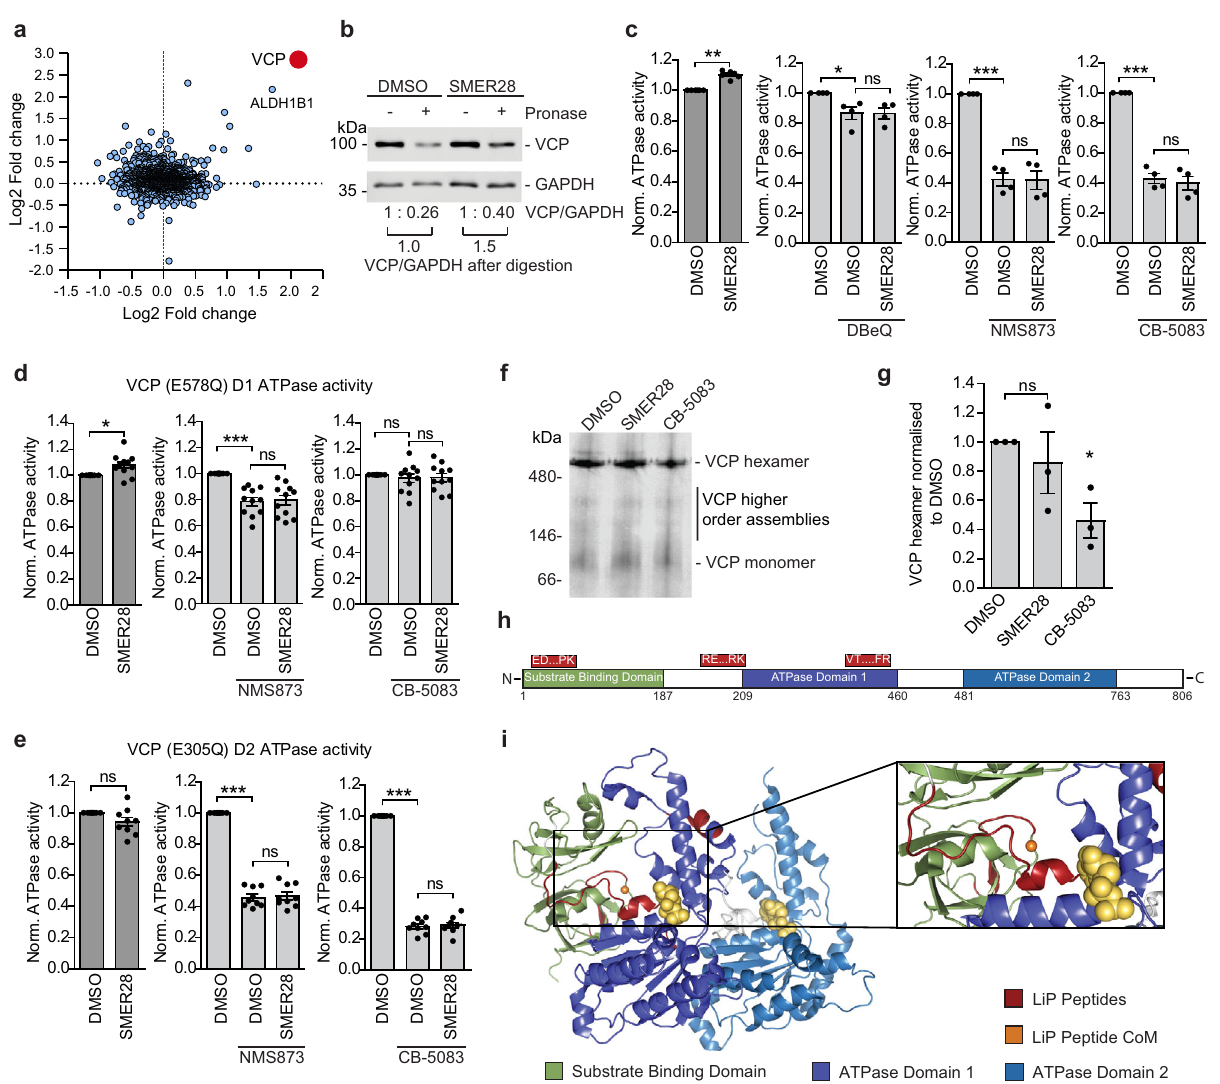
Fig. 2 SMER28 binds VCP and increases VCP D1 ATPase activity. a SMER28 interactors tested in a reverse competition experiment with free compound at 800 µ M. Interactors with a log2-fold-change >2 are labeled in red and were considered signi fi cant. Data point size correlates with a number of unique peptides. b VCP levels after pronase digestion in DARTS assay in lysates from HeLa cells treated with 20 μ M SMER28 for 1 h before lysis. VCP/GAPDH ratio normalized to non-digested samples and ratio in treated samples compared to DMSO control. c – e in vitro ATPase activity of wild-type VCP ( c n = 7),